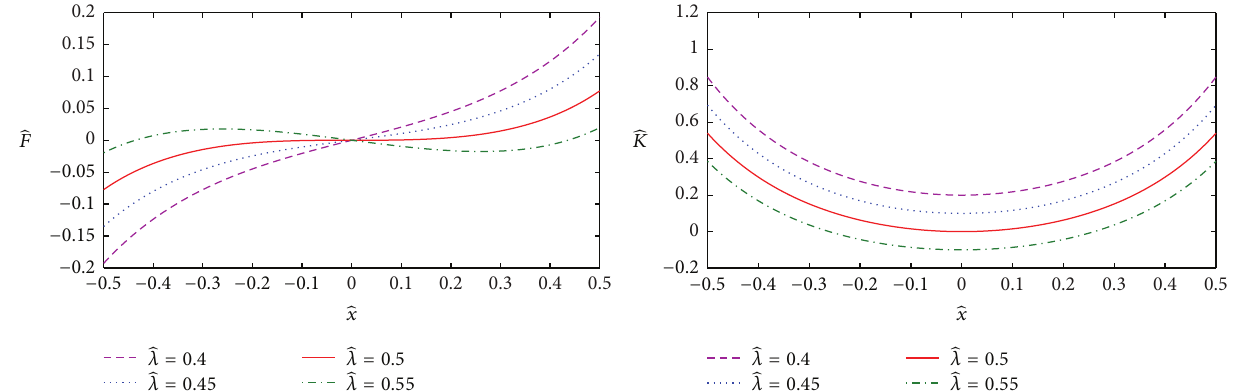
Figure 2: Nondimensional force-displacement and stiffness-displacement